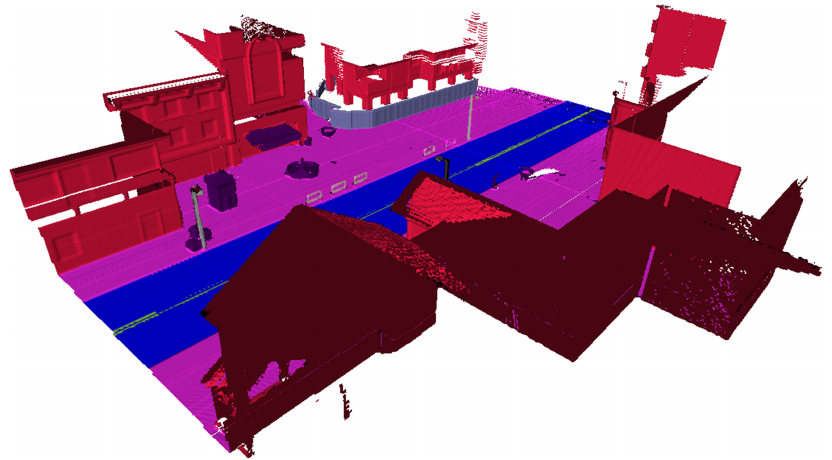
Figure 5. The result of three-dimensional (3D) semantic map. Different colors represent different